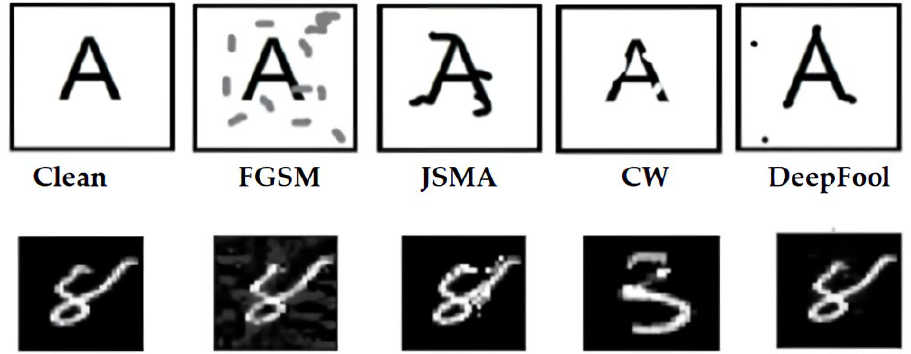
Figure 21. Comparison of benign image and attacked images that are perturbated by FGSM, JSMA, CW, and DeepFool attack.